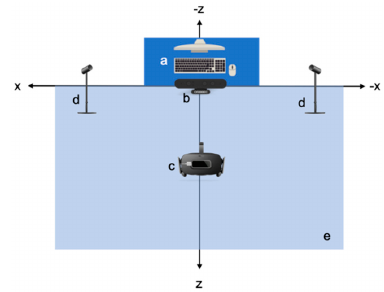
Figure 8. Setup of the VR-MC Tracking System: (a) Desktop Computer, (b) Astra S Body Motion Recognition Camera (BMRC), (c) Oculus Rift VR Headset with attached Leap Motion Controller Hand Motion Recognition Camera (HMRC), (d) Oculus Rift Sensor, (e) VR-MC User Action Area.